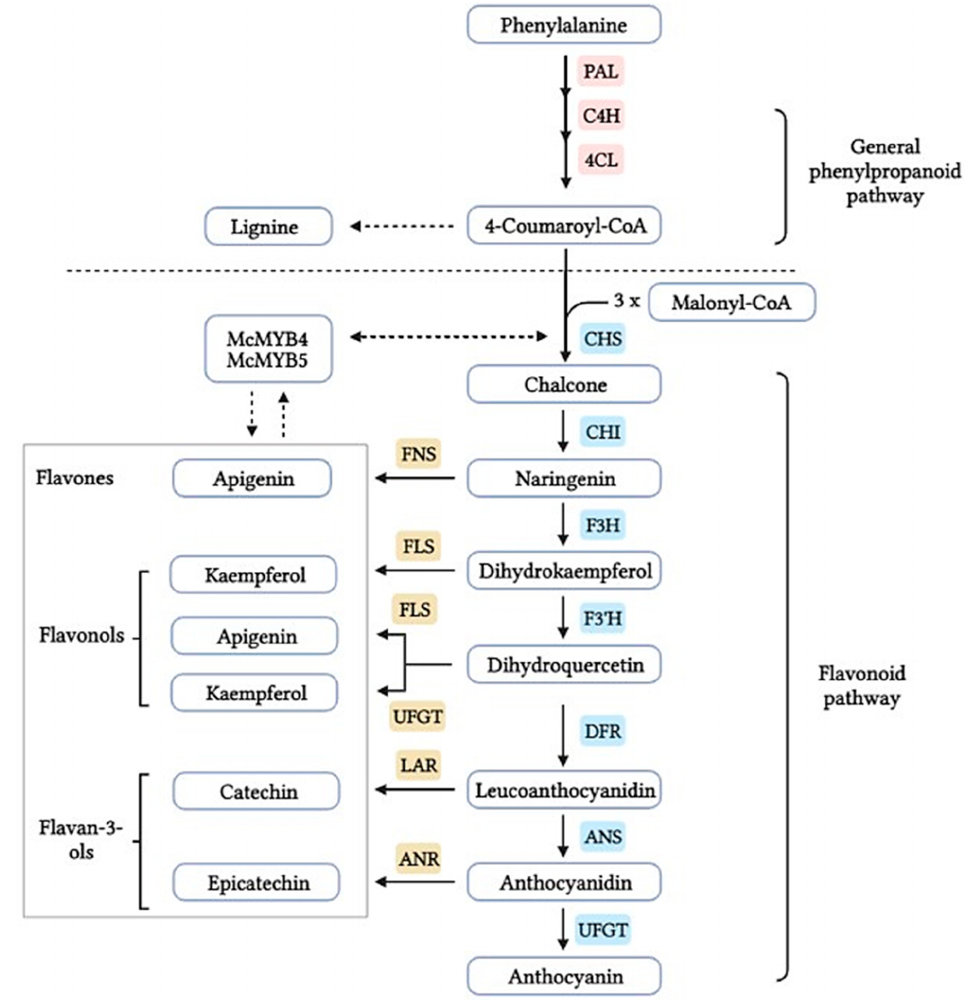
Figure 1. Plant flavonoids biosynthetic pathway [15]. Enzymes for each step are indicated as follows: PAL, phenylalanine ammonia-lyase; C4H, cinnamate 4-hydroxylase; 4CL, 4-coumarate-CoA ligase; CHS, chalcone synthase; CHI, chalcone isomerase; F3H, flavanone 3-hydroxylase; F3 ′ H, flavonoid 3 ′ -hydroxylase; DFR, dihydro-flavonol 4-reductase; FNS, flavonol synthase; FLS, flavonol synthase; LAR, leucoanthocyanidin reductase; ANS, anthocyanidin synthase; UFGT, UDP-glucose: flavonoid- 3- O -glycosyltransferase. (2 S )-Flavanones are converted stereospecifically to the respective (2 R ,3 R )-dihydro- flavonols (DHFs) by flavanone 3-hydroxylase (F3H:EC 1.14.11.9) in this case to dihy- drokaempferol, then converted by the enzyme flavonoid 3 ′ -hydroxylase (F3 ′ H:EC 1.14.14.82) to dihydroquercetin. In Citrus species, the two dihydroflavanols are then con- verted into flavonols under the action of flavonols synthetase (FLS:EC 1.14.20.6). UDP- glucose flavanone-7- O -glucosyltransferase (UFGT:EC 2.4.1.115) and UDP-rhamnose fla- vanone glucoside rhamnosyltransferase (UFGRT) catalyze the conversion of the fla- vanone aglycones into their glucosides and rhamnoglucosides [16]. Dihydroflavonol-4- reductase (DFR:EC 1.1.1.219) is a key enzyme required for both anthocyanin biosynthesis